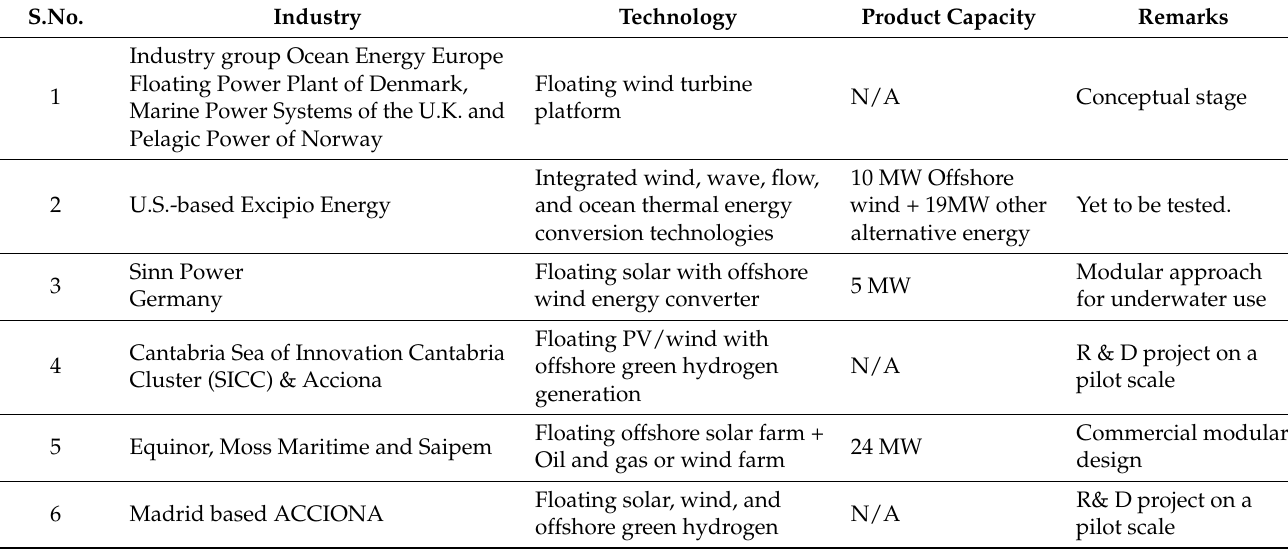
Table 3. Selected Industrial players in Hybrid